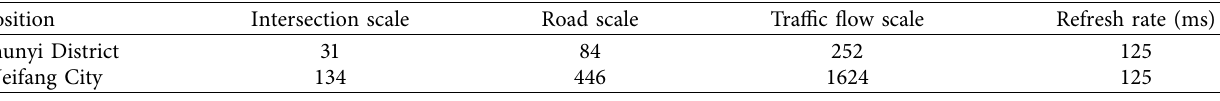
Table 2: Simulation of road networks and traffic flow